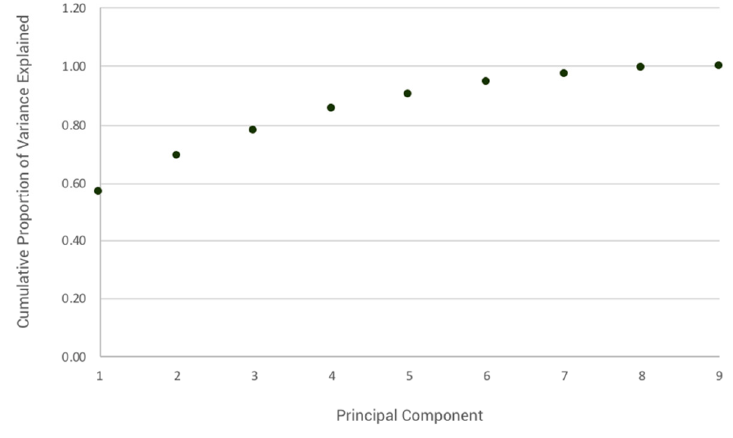
Figure 4. Plot showing the cumulative proportion of the variance explained for each PC. The first 5 PC’s account for 90.39% of the total variance. Table 4. PC loadings resulting from the dimension based